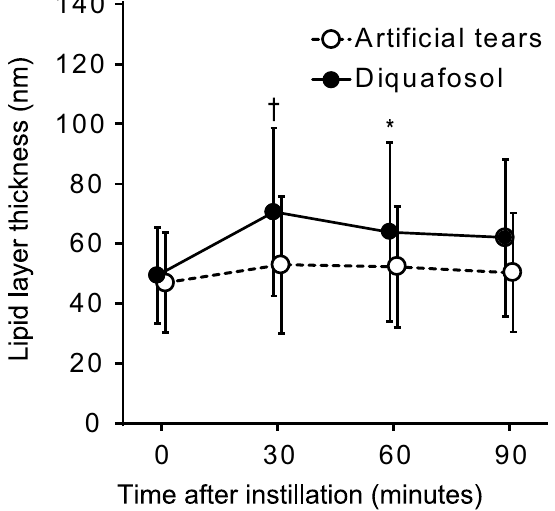
Figure 1. Time course for lipid layer thickness of the tear film before and after artificial tear or diquafosol administration. Data are shown as means ± standard deviations ( n = 47). * Adjusted P < 0.05, † adjusted P < 0.001 versus corresponding preadministration (time 0) value (Wilcoxon signed-rank test with Bonferroni’s adjustments for three tests).